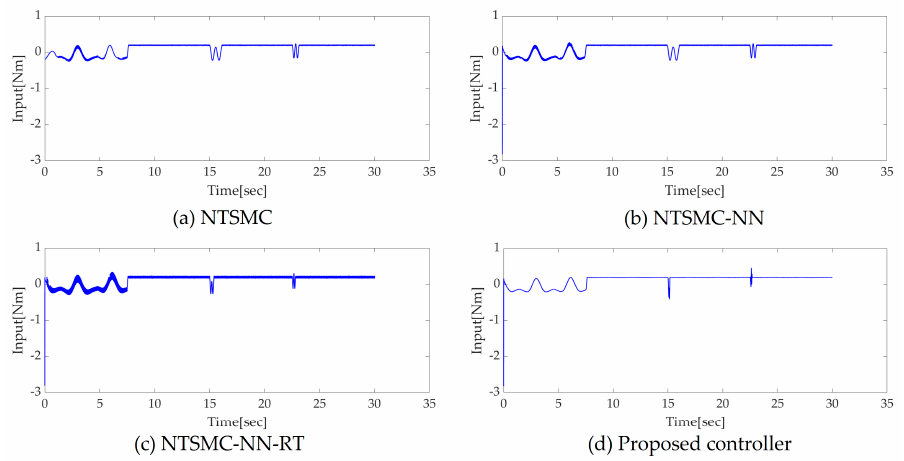
Figure 21. Mixed input control input θ 2 control performance. ( a ) NTSMC input result; ( b ) NTSMC- Figure 21. Mixed input control input 𝜃 (cid:2870) control performance. ( a ) NTSMC input result; ( b ) NTSMC-